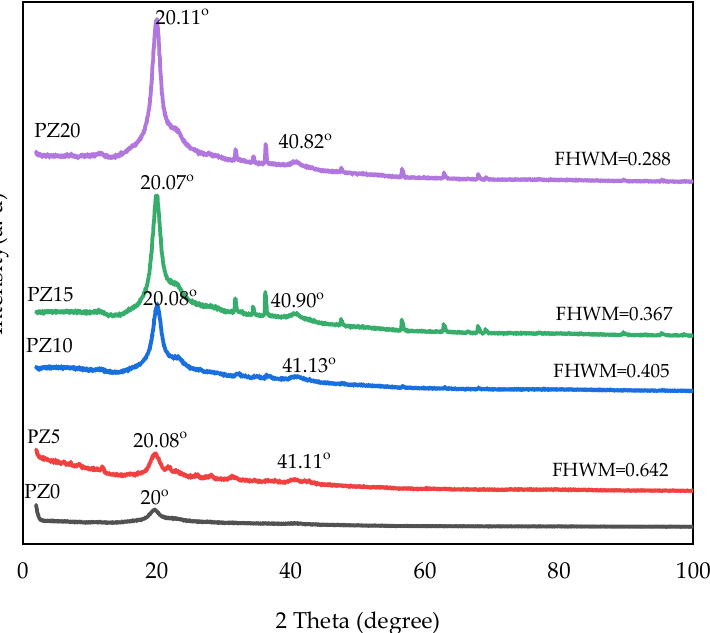
Figure 2. XRD pattern of PVA–CA–K 2 CO 3 composite SPEs (PZ0) and PVA–CA–K 2 CO 3 composite SPEs with varying concentrations of ZnO-NPs from 5 to 20 wt % (PZ5 to PZ20).